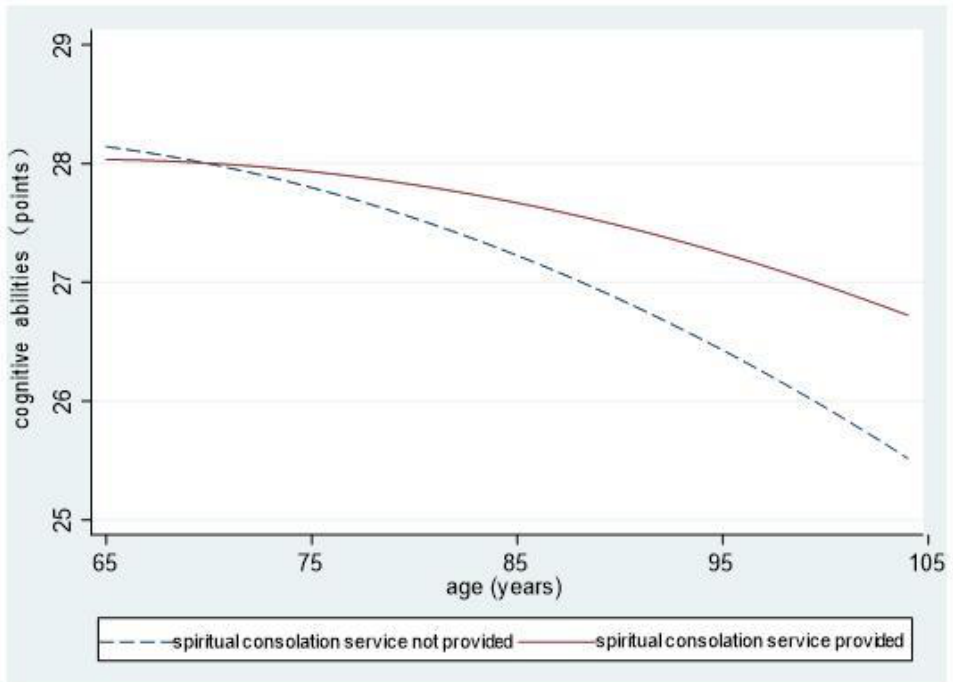
Figure 3. The influences of communities providing spiritual consolation services on cognitive abilities.